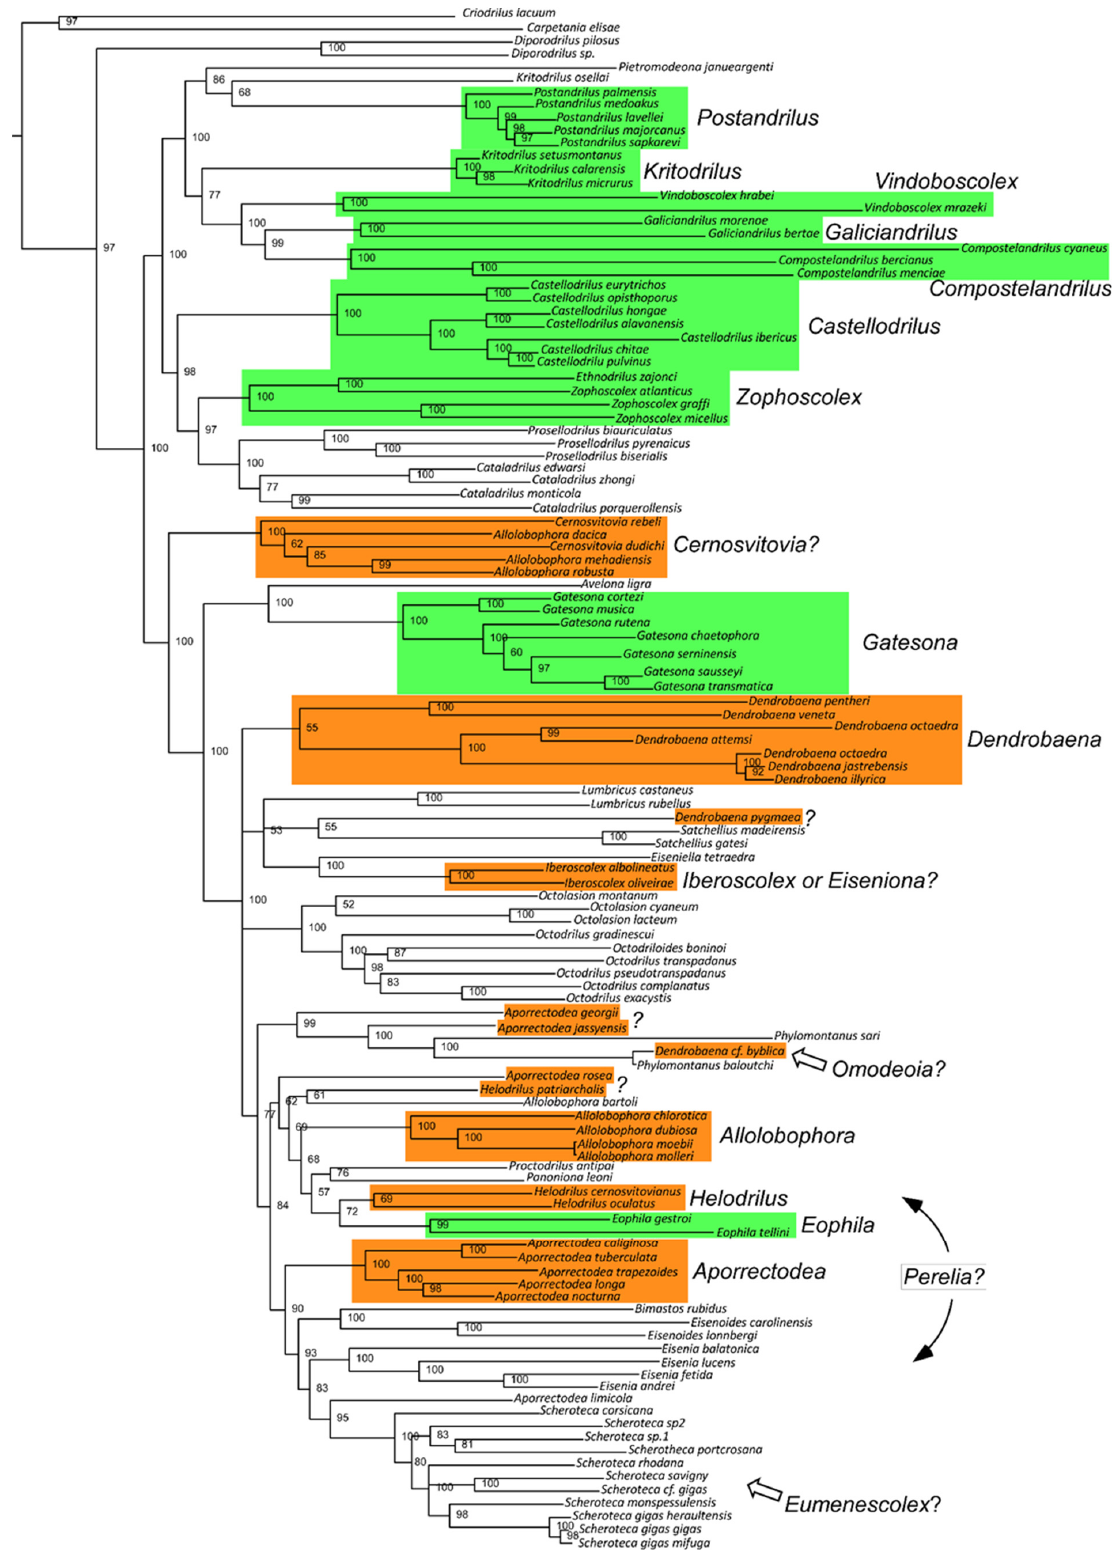
Figure 2. Modified from [48]. Bayesian phylogenetic inference based on the concatenated sequences of the molecular markers COI, COII, 16S, tRNAs (Ala, Leu), 12S, ND1, and 28S. Clades referenced in the main text are highlighted in different colours; clades for which significant advances have been achieved are shown in green; clades for which remaining questions exist are shown in orange.